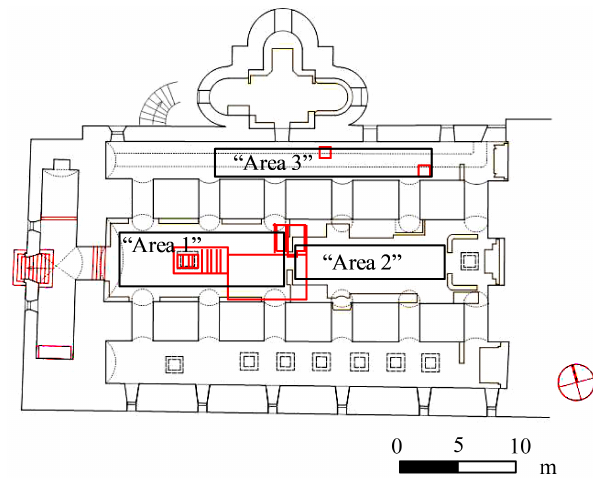
Figure 7. Map of the Church of Santa Croce with the three inves- tigated areas, with the map of the underlying crypt and with two manholes evidenced in red